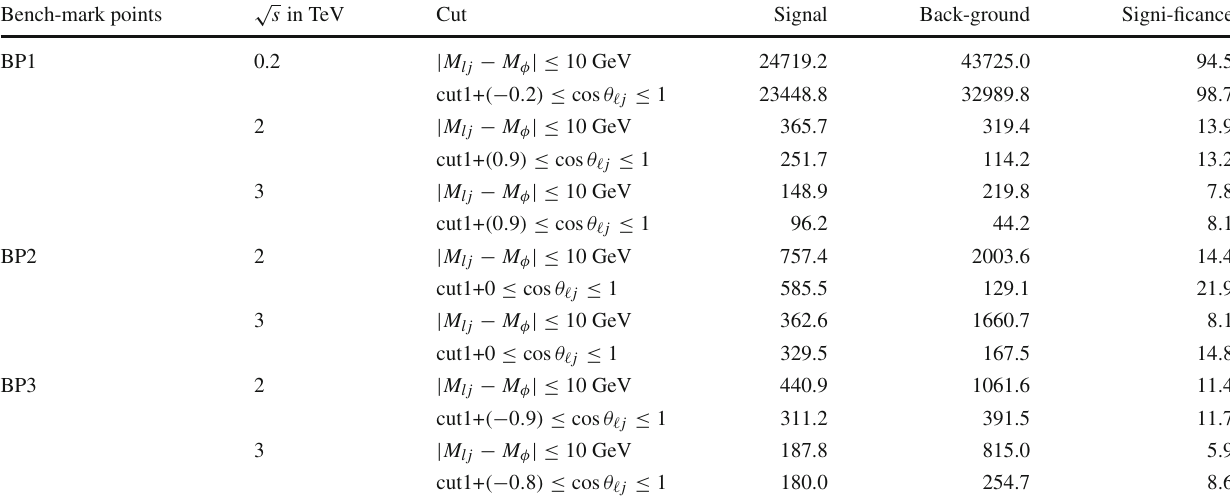
/ 3 ) c with luminosity 100 fb − 1 at e – γ collider 2